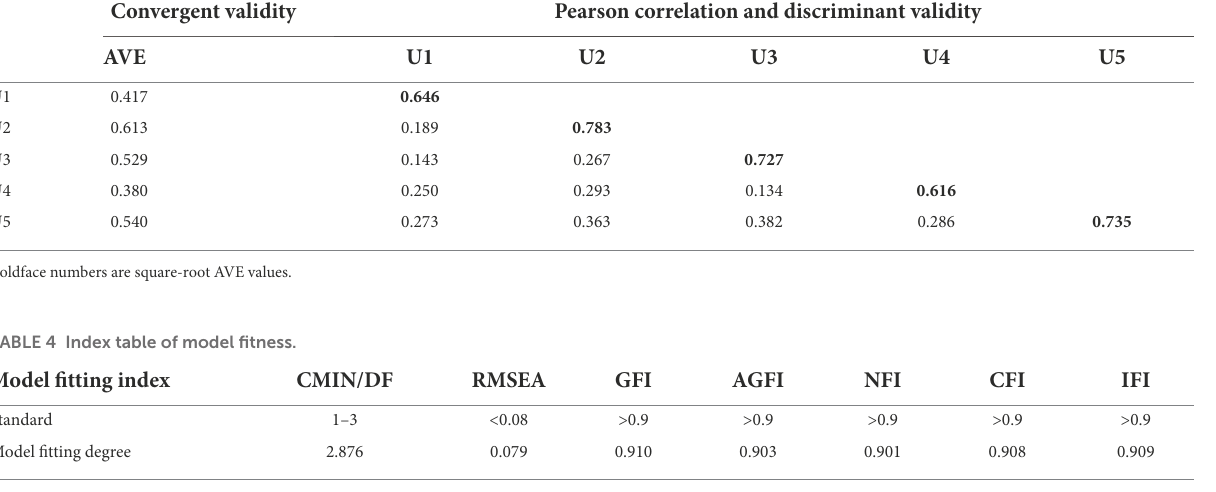
TABLE 3 Discriminant validity